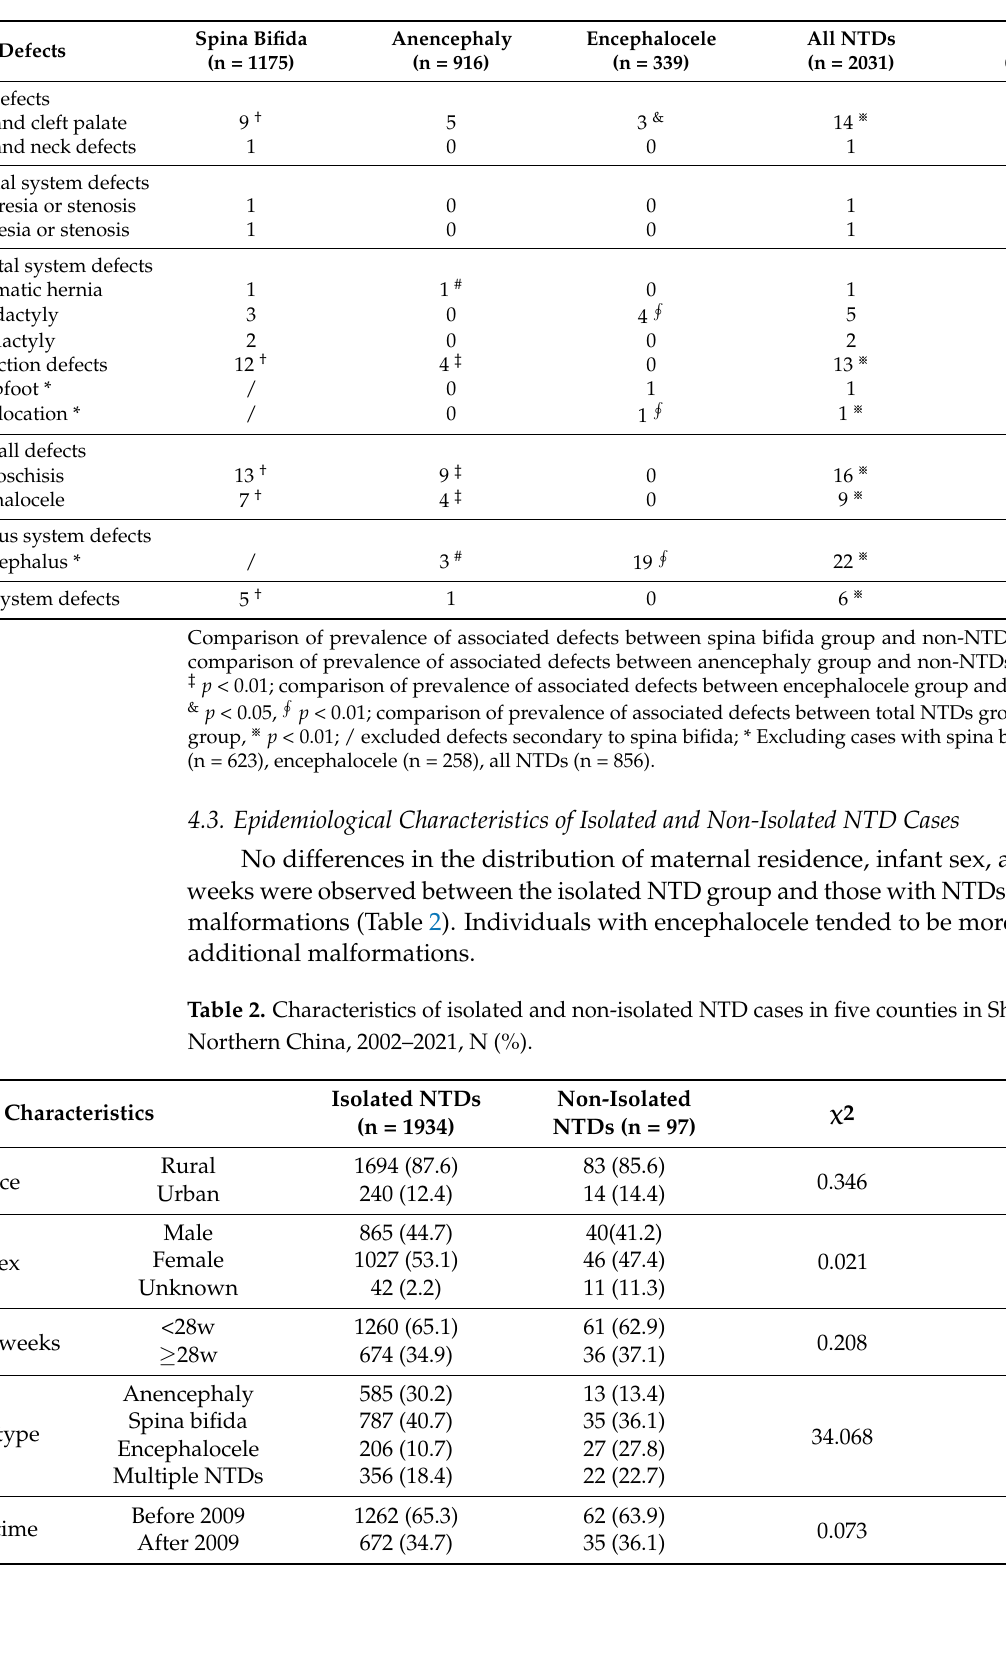
Table 1. Associated defects in three NTDs by subtype groups and non-NTD group in five counties in Shanxi province of Northern China, 2002–2021.